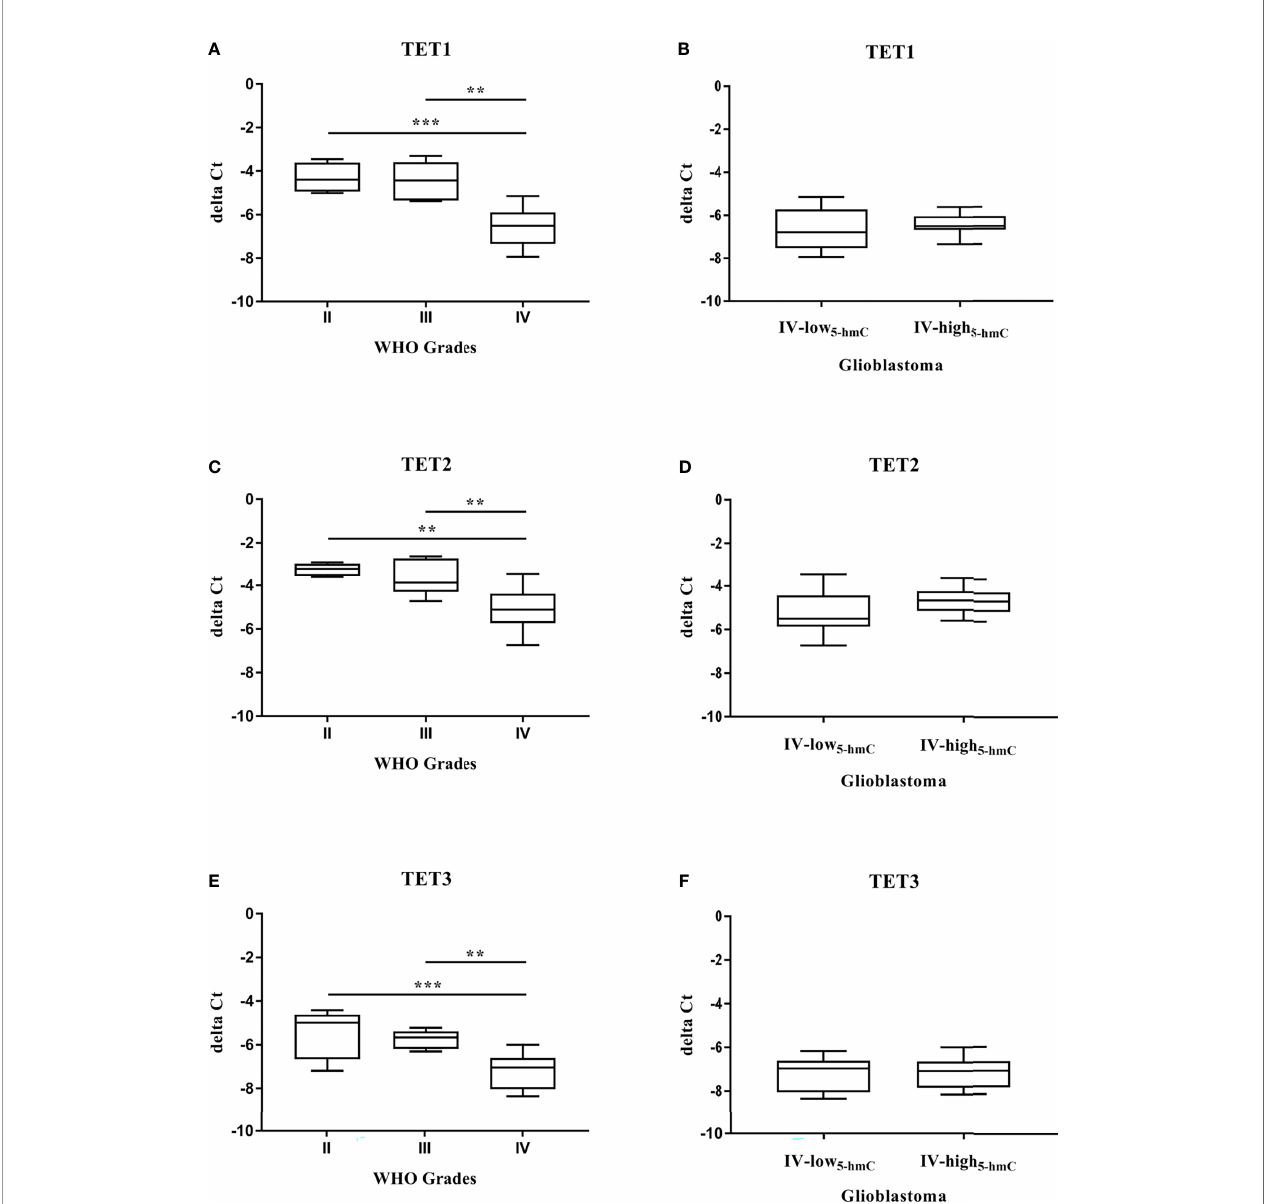
FIGURE 2 | Quantitation of TET transcripts in gliomas. qRT – PCR analysis of TET mRNA (A – F) . The expression of TET1 (A) , TET2 (C) , TET3 (E) mRNA signi fi cantly decreased at a higher WHO grade of glioma. Differences among group means were evaluated by one-way ANOVA test (**p < 0.01, ***p < 0.001). High variability in 5-hmC abundance across glioblastoma (Grade IV-low 5-hmC and Grade IV-high 5-hmC ) was not linked with levels of TET1 (B) , TET2 (D) , TET3 (F)